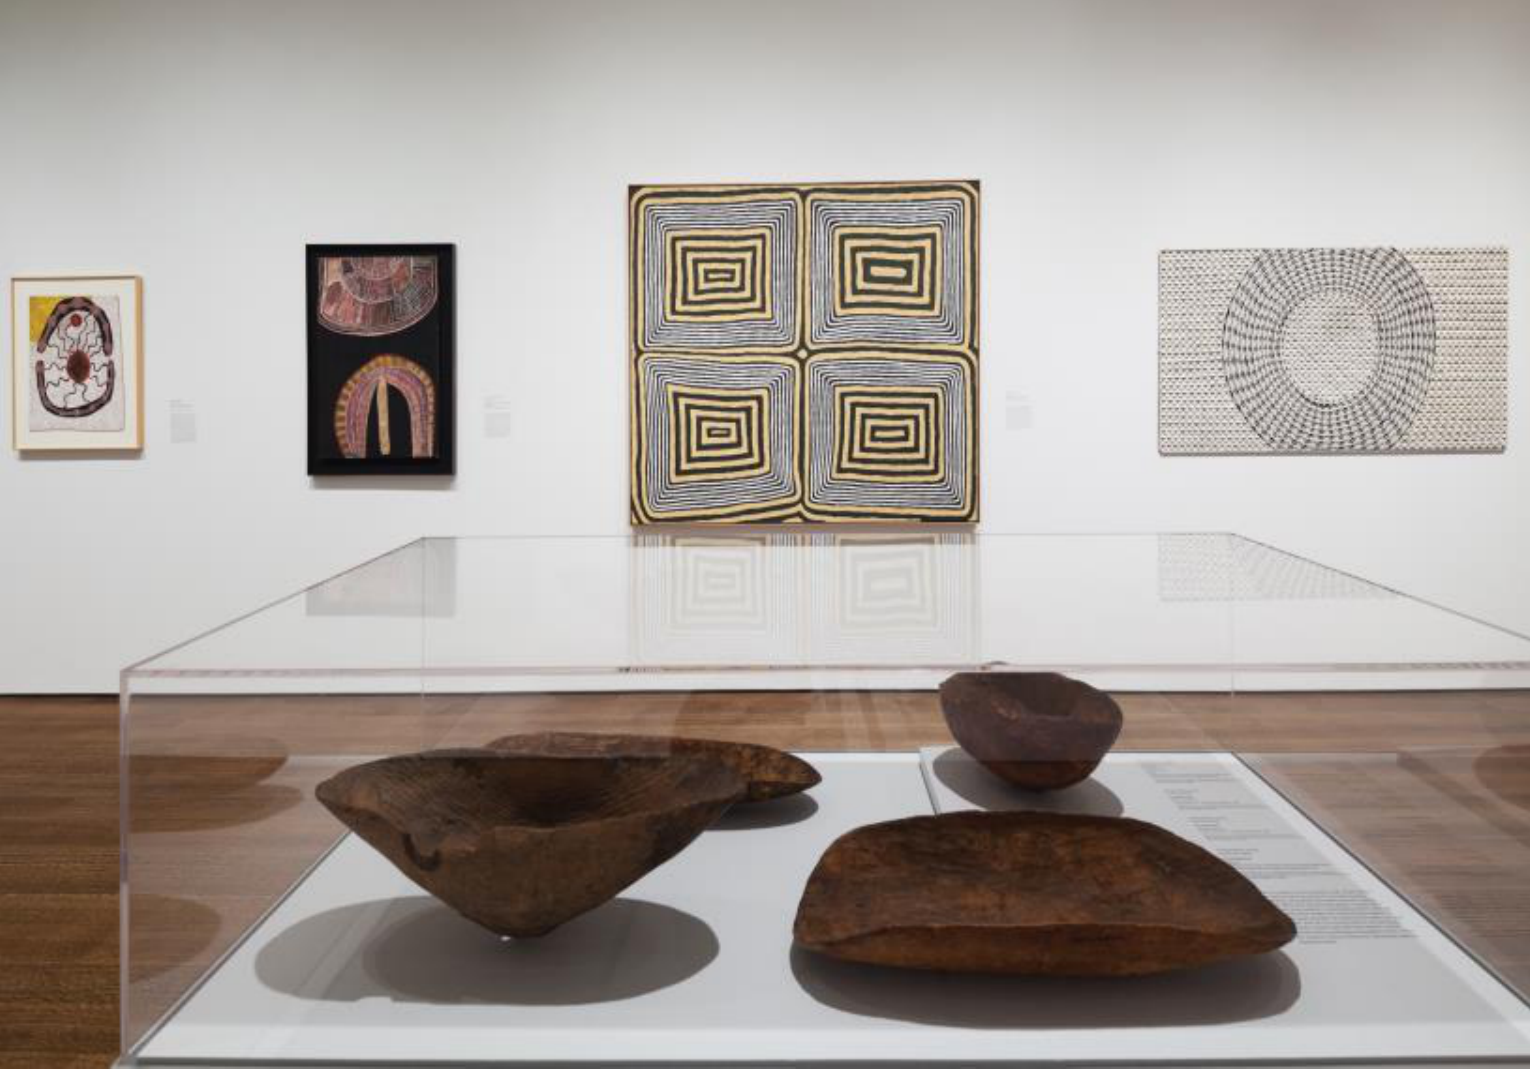
Contemporaneity: Historical Presence in Visual Culture http://contemporaneity.pitt.edu Vol 5, No 1 “Agency in Motion” (2016 ) | ISSN 2155-1162 (online) | DOI 10.5195/contemp.2016.183